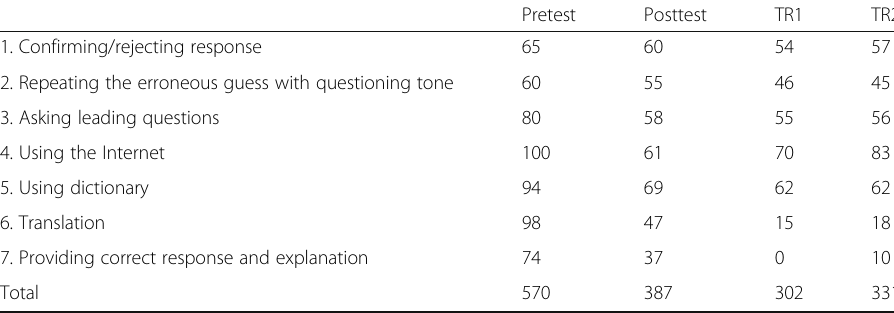
Table 20 Descriptive Analysis: Frequency of Meditational